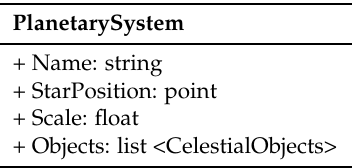
Table 1. Model of planetary systems.